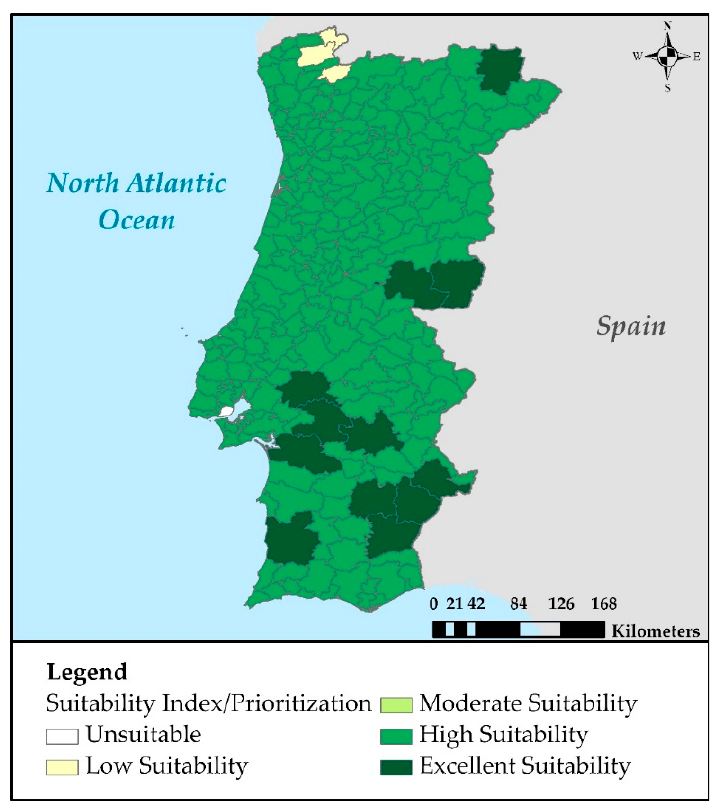
Figure 4. Prioritization results of the municipalities of the Portuguese mainland.